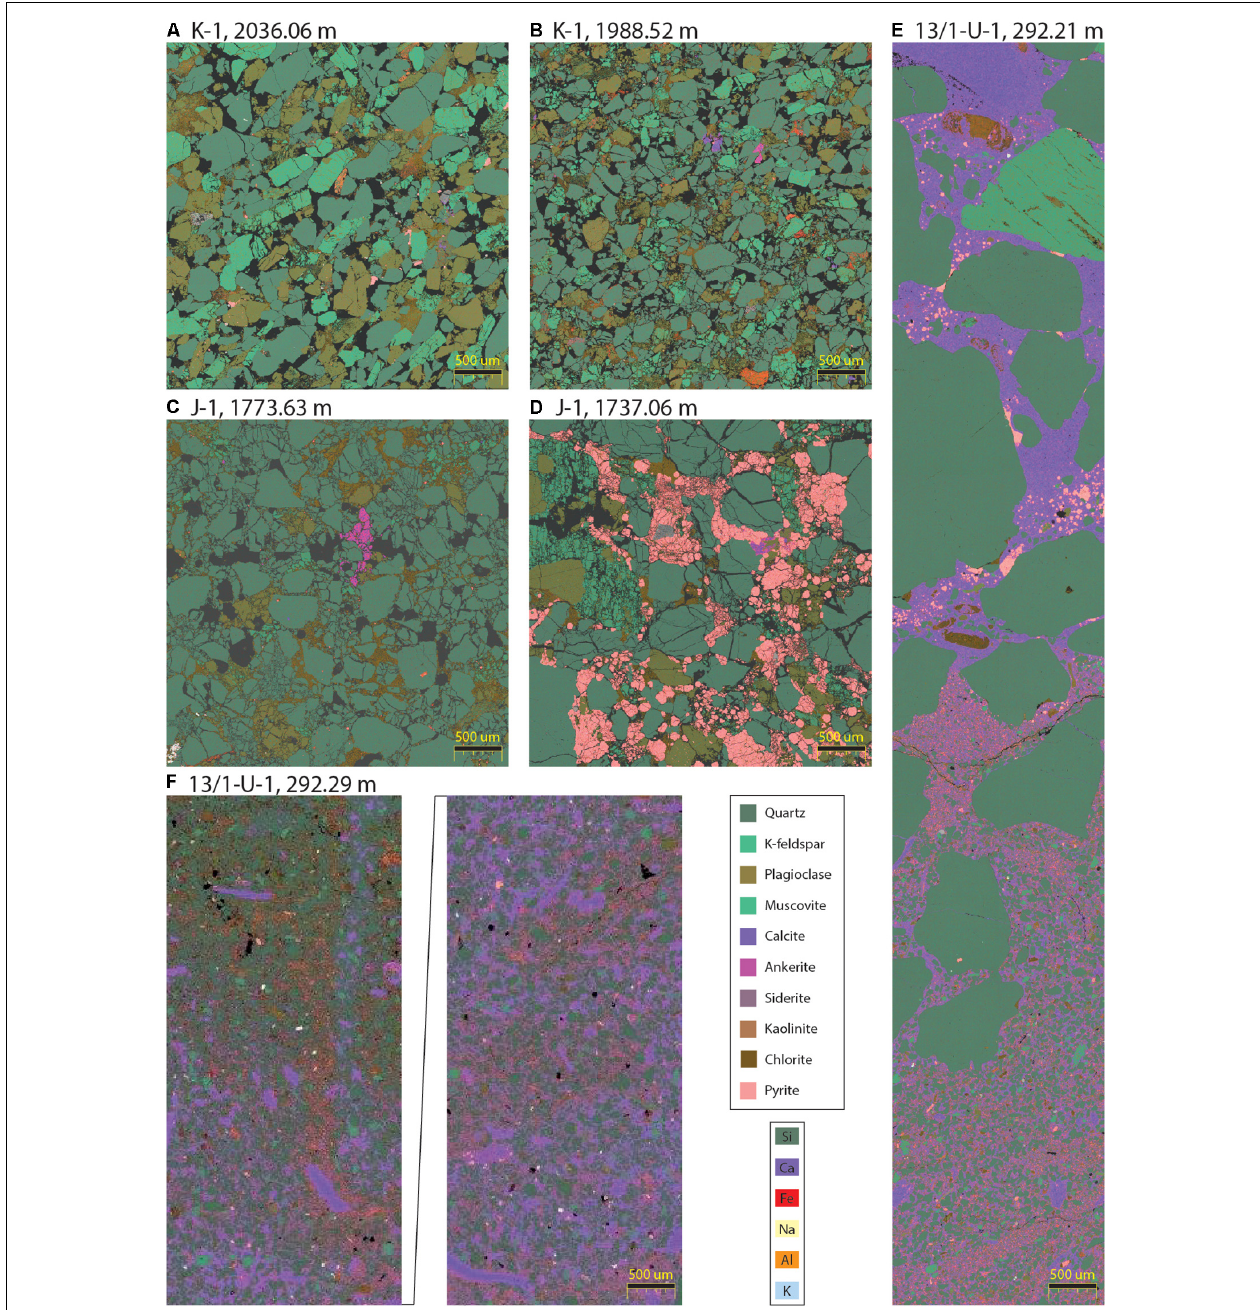
FIGURE 9 | Mineral semi-quantification by SEM element scanning. (A–D) Sandstones from sidewall cores from the K-1 and J-1 wells are dominated by quartz grains besides plagioclase/albite and K-feldspar grains, whereas authigenic phases occur in small amounts except for pyrite cement in D that may represent a local pyrite concretion. (E) The conglomerate in the 13/1-U-1 core contains clasts of quartz, feldspar, fossil fragments and chlorite ooids embedded in ankerite cement. (F) The lower sandstone in the 13/1-U-1 core is cemented by low-Fe calcite.